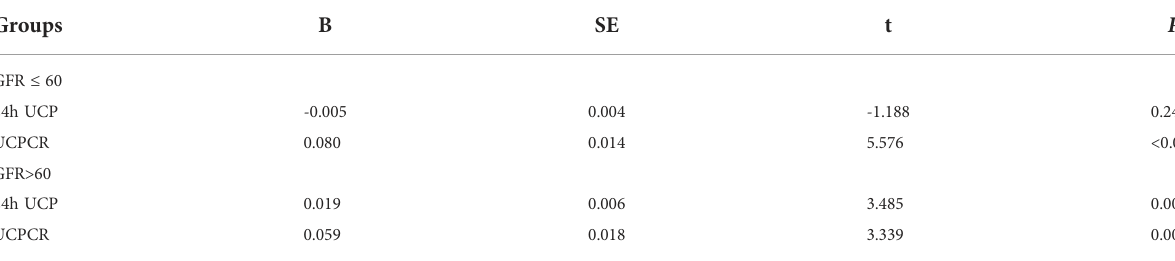
TABLE 2 Results of multiple linear regression analysis.